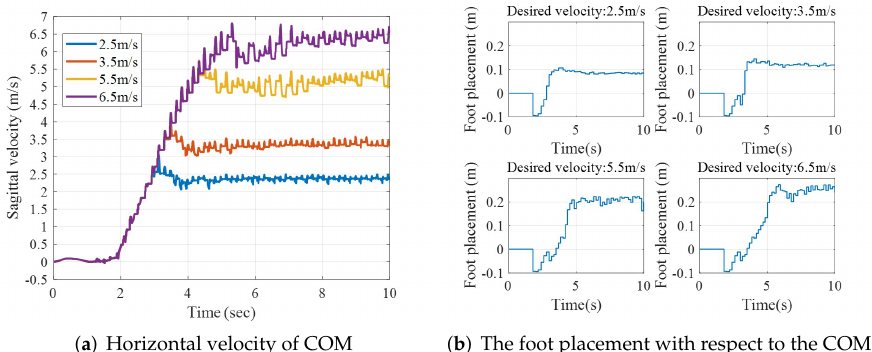
Figure 9. Simulation results for different target